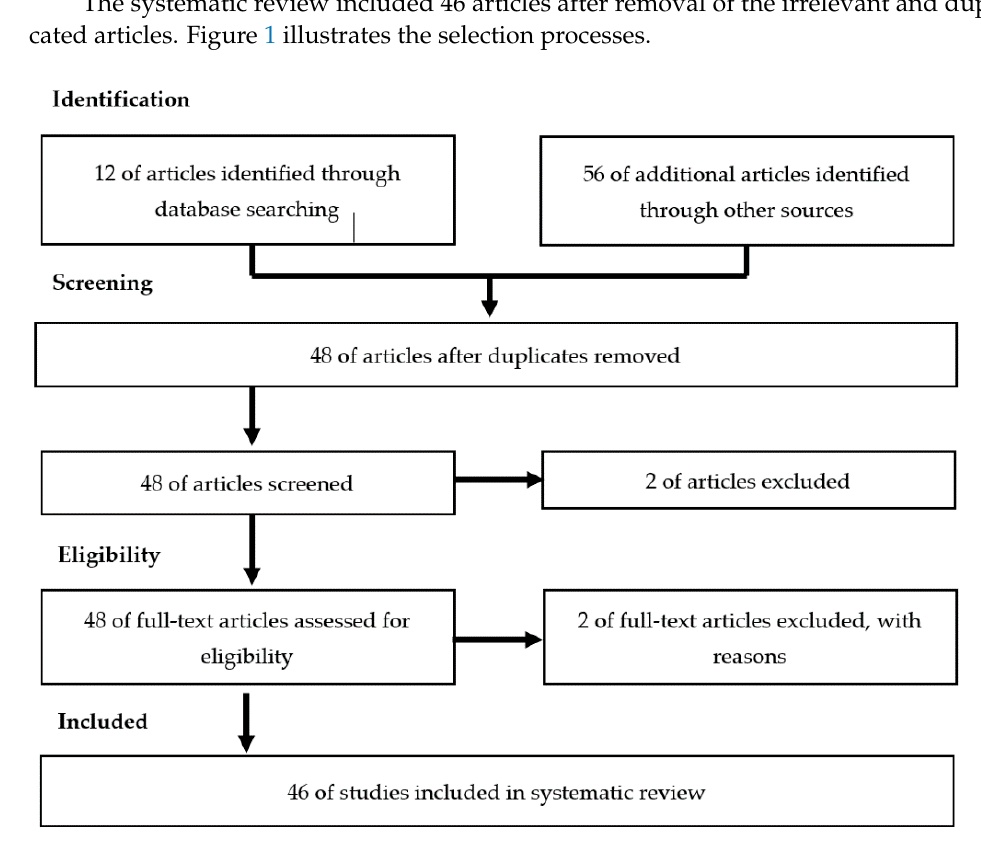
Figure 1. Article Selection Processes.